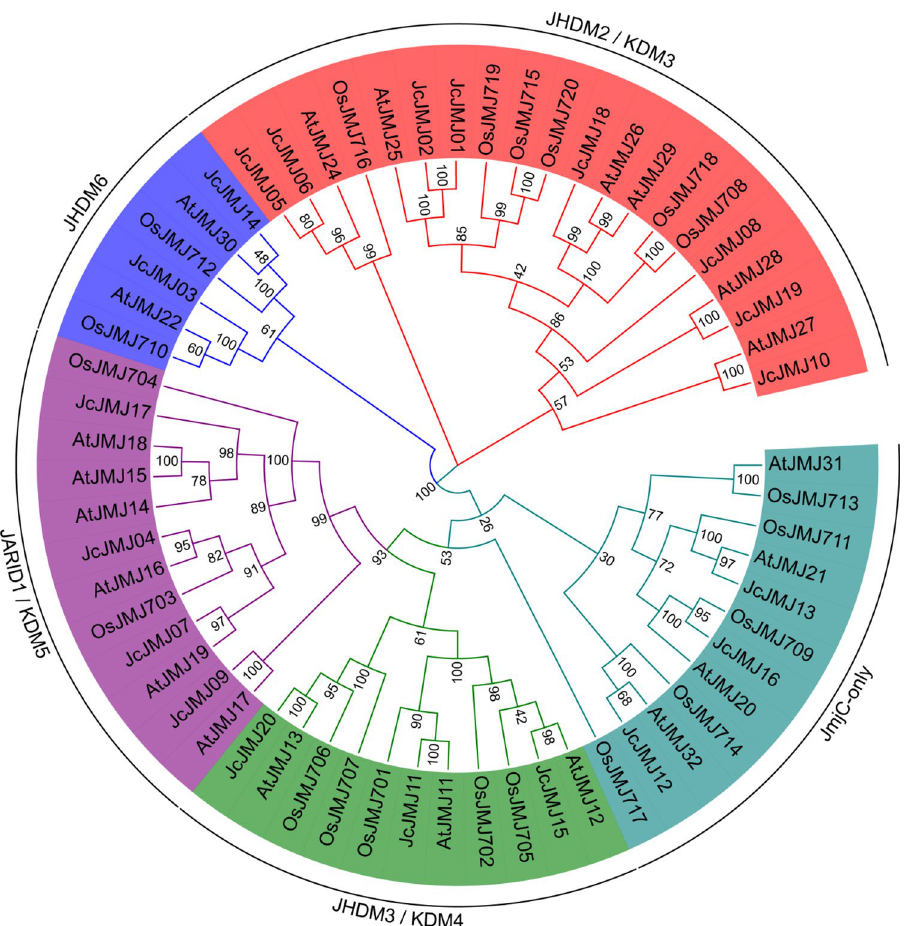
Figure 1. Phylogenetic relationship of JMJ genes in J. curcas , Oryza sativa and Arabidopsis thaliana . JMJ genes are clustered into five groups which are marked by different colors. The bootstrap values are marked on the nodes with omitted “%”.